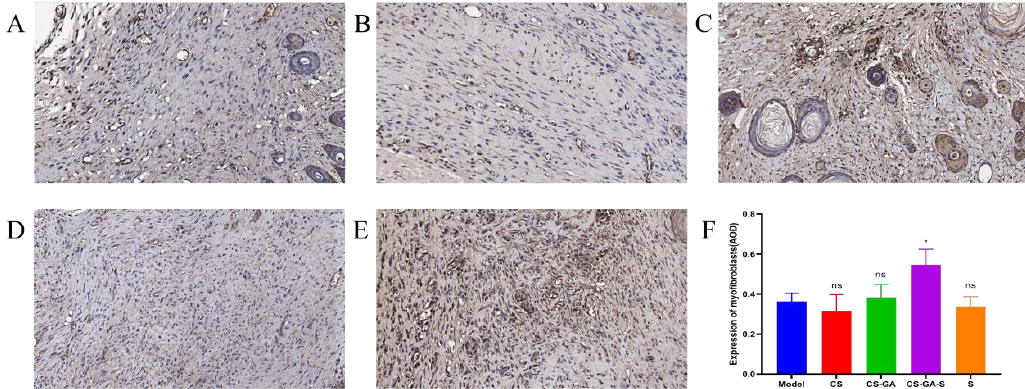
Figure 14. Representative IHC images of regenerated wound tissues with anti-HSP47. ( A ) Model group, ( B ) CS group, ( C ) hydrogel group, ( D ) scolopin2 group, and ( E ) CS-GA-S group ( × 600 ) . ( F ) The expression of fibrocytes was semi-quantified. ns represents no significance, ** represents p < 0.005.